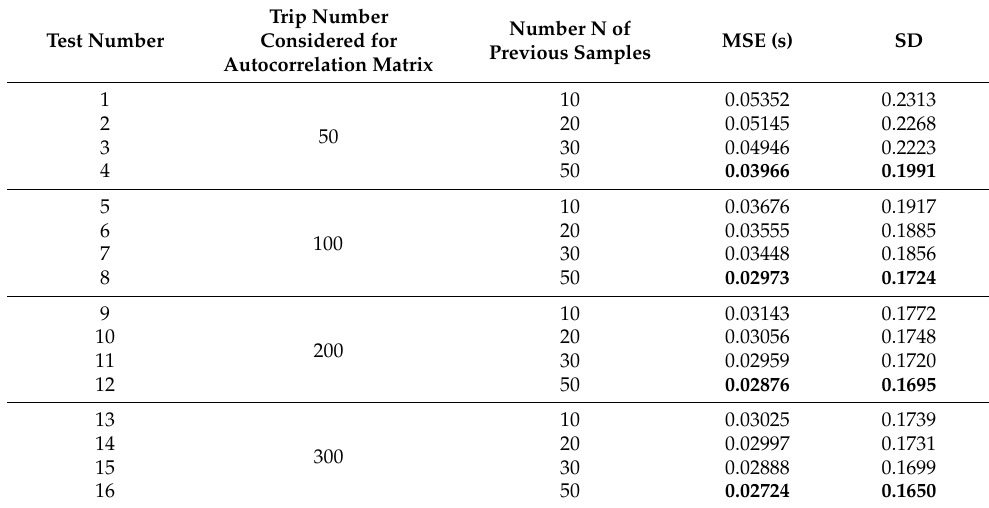
Table 4. Calculation of MSE and SD for different combinations of routes and considering previous samples.